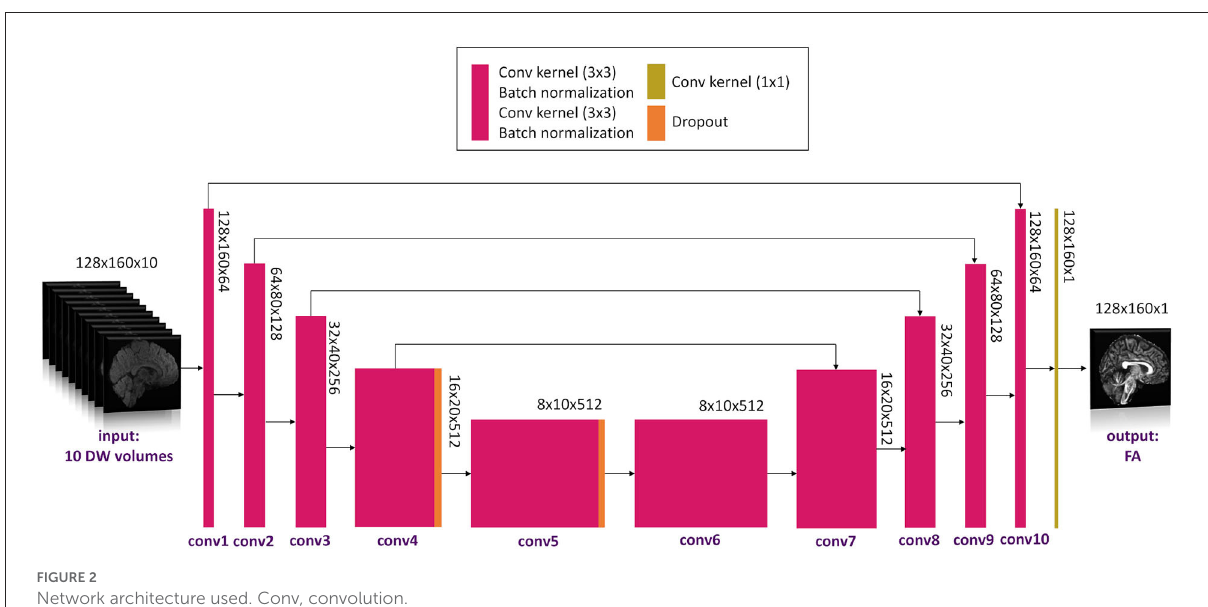
FIGURE2 Network architecture used. Conv,